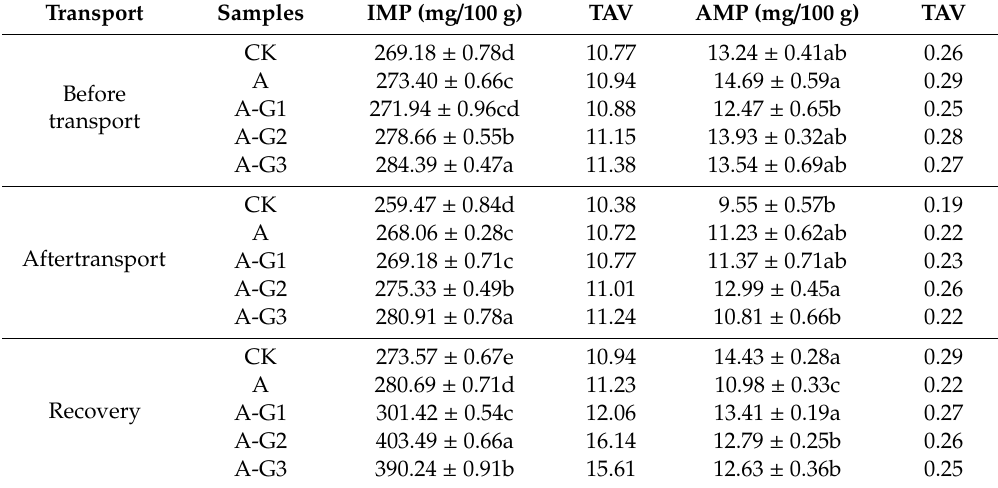
Table 6. E ff ect of ascorbic acid and β -1,3-glucan addition on nucleotides of tiger grouper during simulated transport in